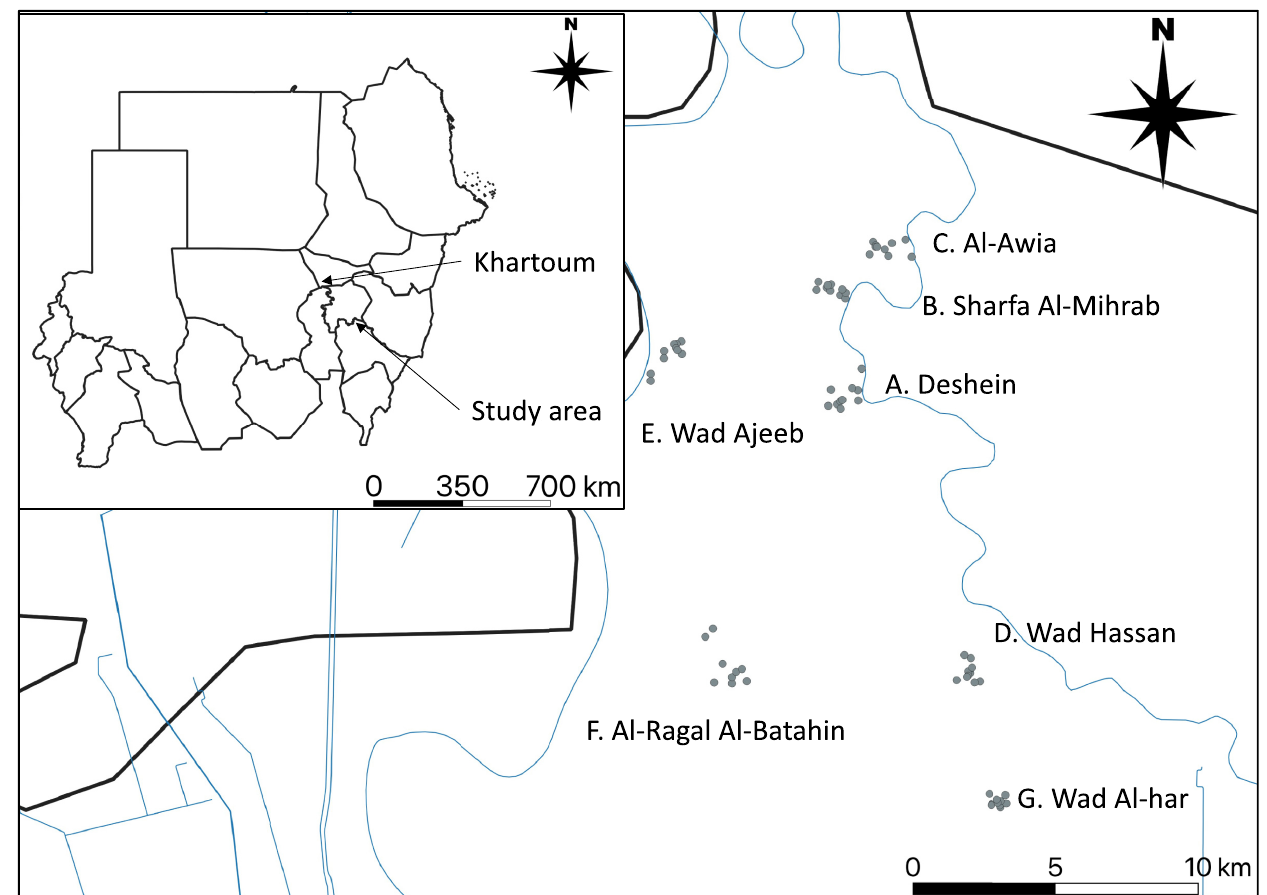
Fig 1. The geographical location of areas where soil samples were collected in this study. Each point on the map presents a sample collection site. Country and state maps were obtained from the GADM database under a CC BY license (https://geodata.ucdavis.edu/gadm/gadm4.0/shp/gadm40_SDN_shp.zip). Waterways (blue line) data were downloaded from the OpenStreetMap project (OpenStreetMap contributors) under a CC BY-SA 2.0 license (www. openstreetmap.org) through the platform Geofabrik (https://download.geofabrik.de/africa/sudan-latest-free.shp.zip). The map was created using the QGIS Geographic Information System, Open Source Geospatial Foundation Project, under a CC BY-SA 3.0 license (http://qgis.osgeo.org).